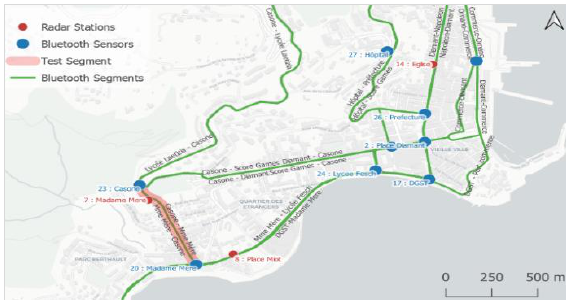
Figure 4: Radar stations and Bluetooth sensors placed in Ajaccio’s road network. The segment highlighted in red will be used to compare TomTom FCD speeds against the Bluetooth sensors speeds in both directions.